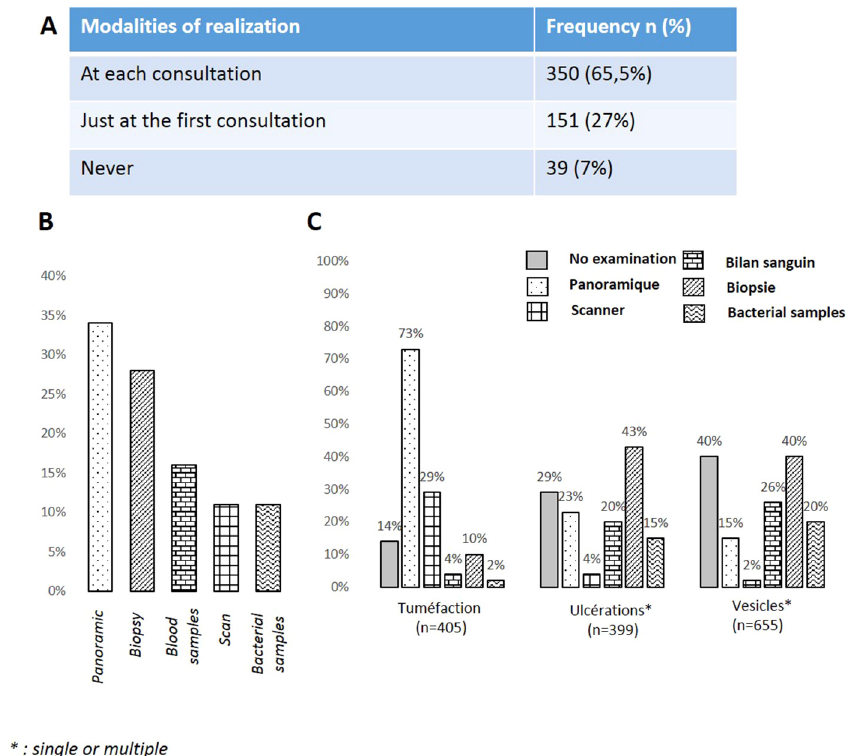
Fig. 3. Oral lesions: initial assessment, complete clinical examination and prescription of additional examinations. (A) Frequency and modality of performing complete clinical examination. (B) Type of additional examinations prescribed when a dental surgeon identi fi es an oral lesion (all types of lesions confounded). (C) Type of additional examinations prescribed according to the type of the